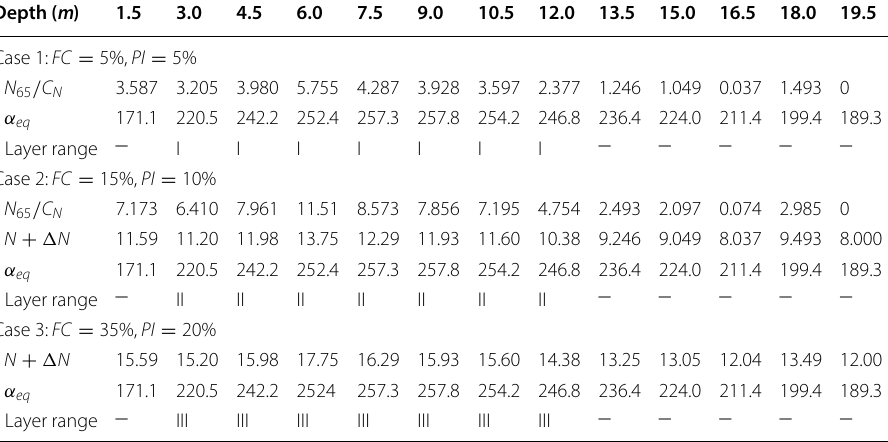
Table 6 Calculation details of liquefaction probability through OCDI [9] method for borehole